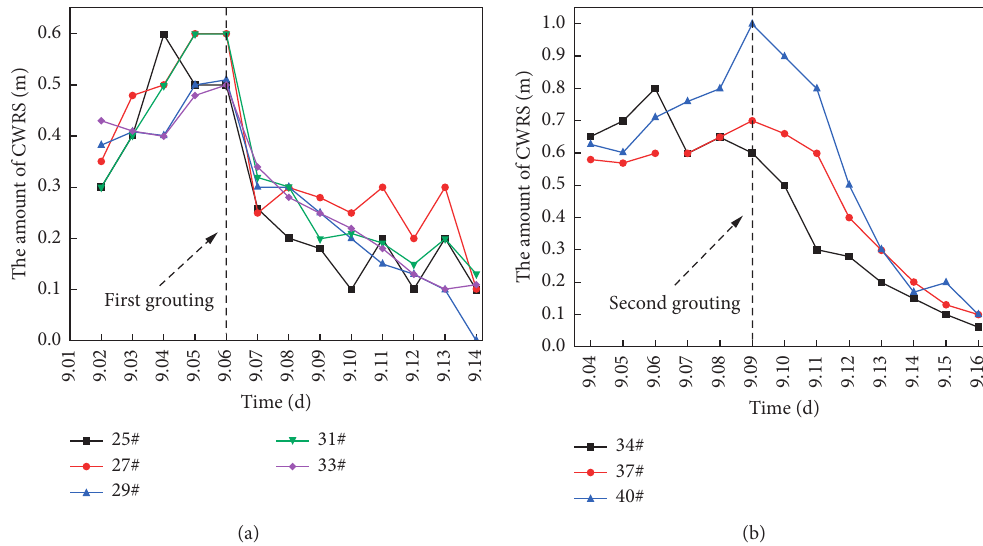
Figure 14: The amount of rib spalling before and after two groutings. (a) First grouting. (b) Second grouting.